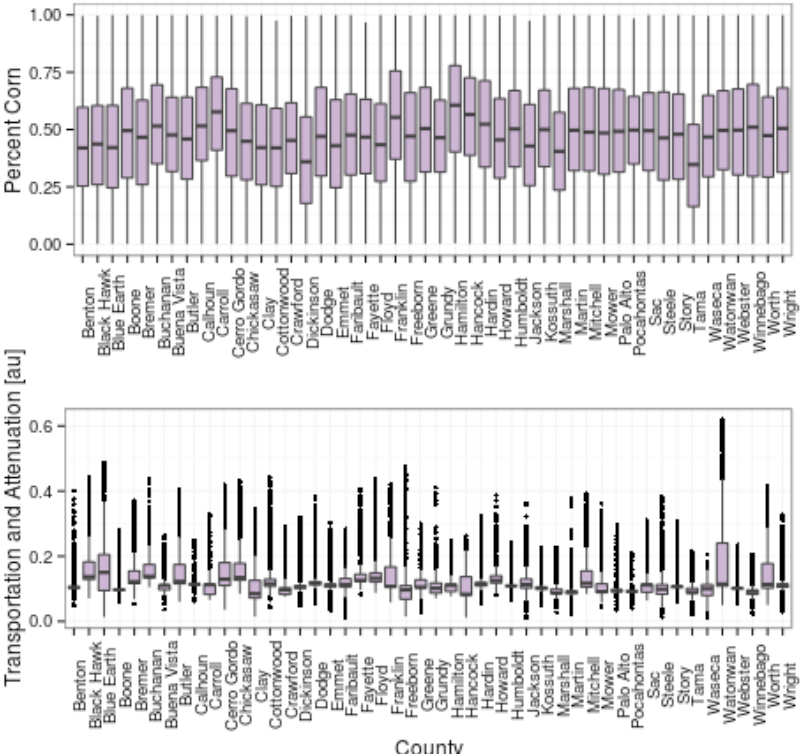
Fig. S2 Soil and management characteristics of each county. The top plot shows the dominance of corn across the study area. The data behind this plot is used to calculate total yield for each county as a function of cropped corn area. The bottom plot shows transportation and attenuation by county. All counties are greater than 10,000 km 2